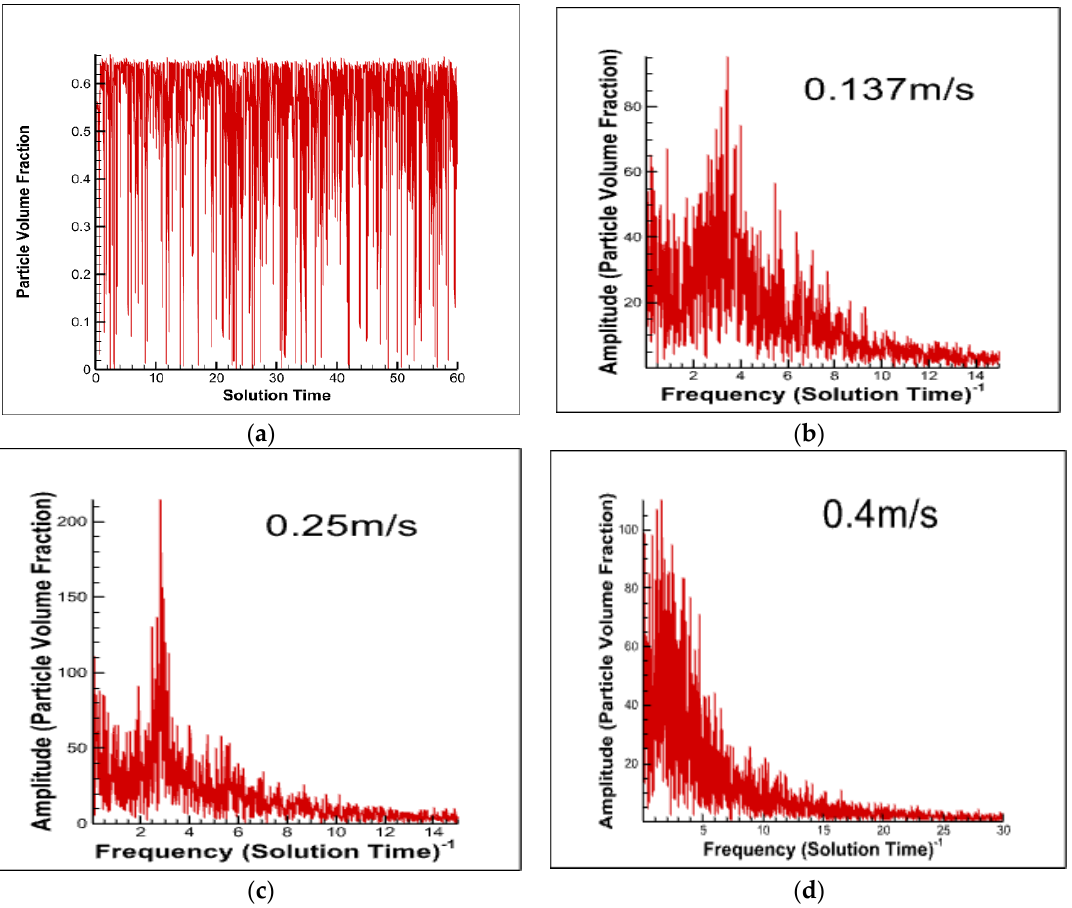
Figure 12 . Figure showing: ( a ) fluctuation of particle volume fraction with time; ( b - d ) Fourier transform of the particle volume fraction for superficial gas velocities 0.137 m/s, 0.25 m/s, and 0.4 m/s, respectively.